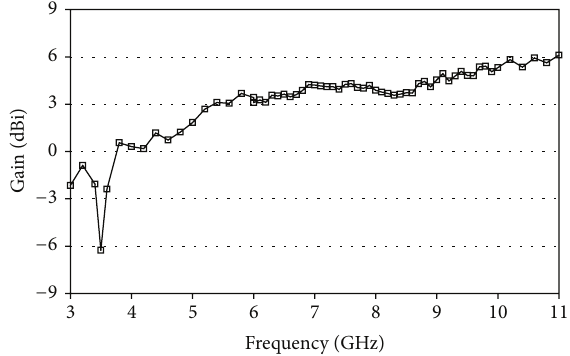
Figure 8: Measured peak gain of the proposed